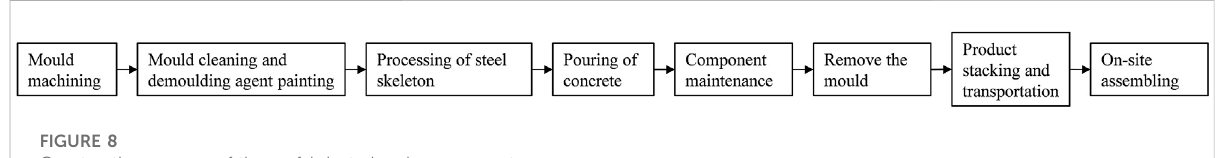
FIGURE 8 Construction process of the prefabricated curb components.